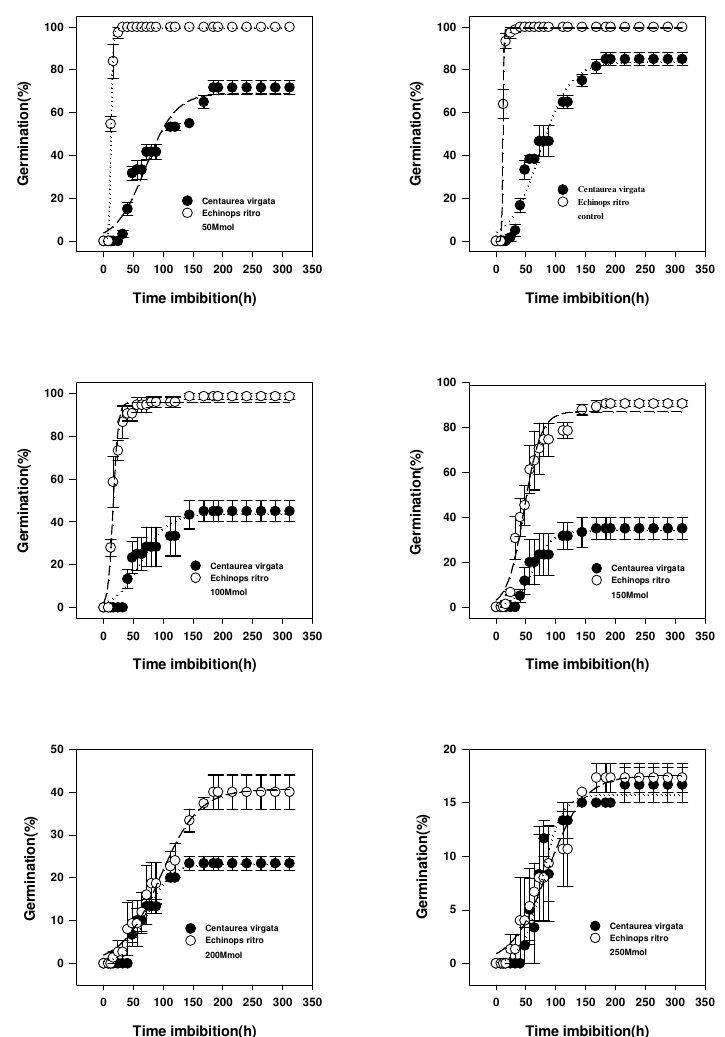
Figure 1. Seed germination rate of two weed species affected by salinity stress treatments Table 2. Estimated of parameters logistic on final germination and vigor index of two weeds Echinops ritro and Centaurea virgata in response to salinity levels Final germination Vigor index NaCl